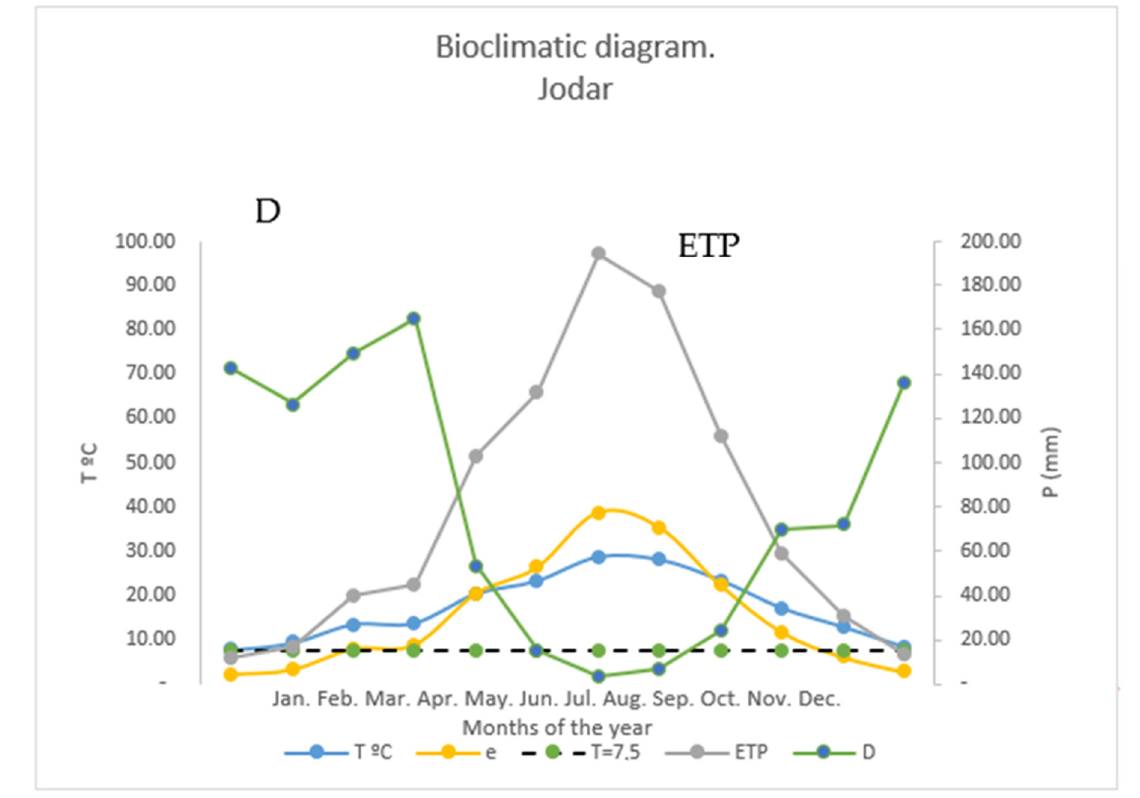
Figure 4. Bioclimatic diagram for Jodar: P = precipitation. ETP = potential evapotranspiration. D = water availability. R = soil water reserve. e = residual evapotranspiration.